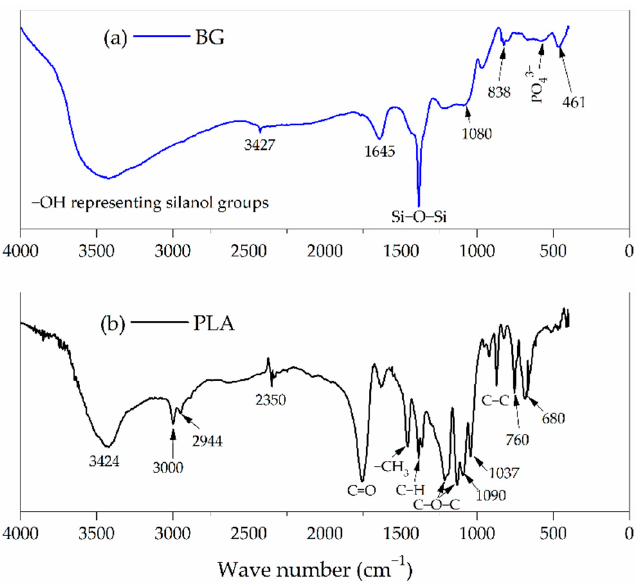
Figure 2. FTIR spectra for the synthesized species (a)BG and (b) PLA.